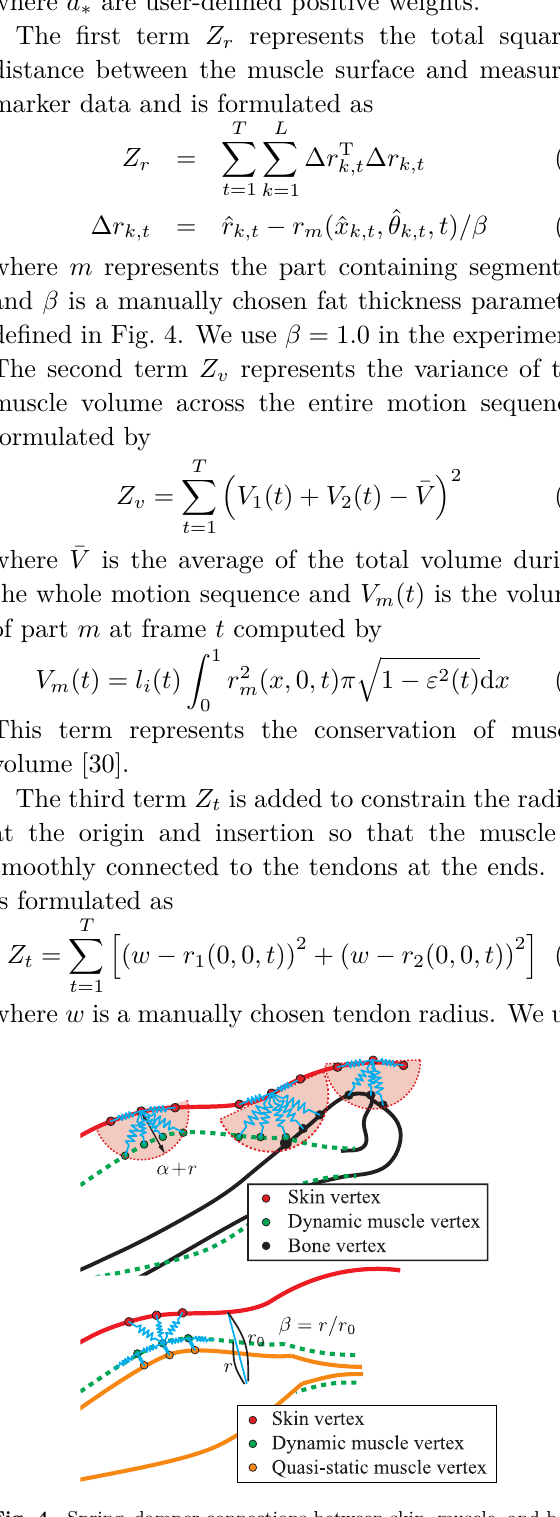
Fig. 4 Spring–damper connections between skin, muscle, and bone vertices, where r is the distance from each skin vertex to the nearest vertex on the muscles or bones. Muscle vertices (orange dots) or bone vertices (black dots) within α + r ( α > 0) are connected to the skin vertex by springs and dampers. β represents the average relative thickness of muscles with respect to soft